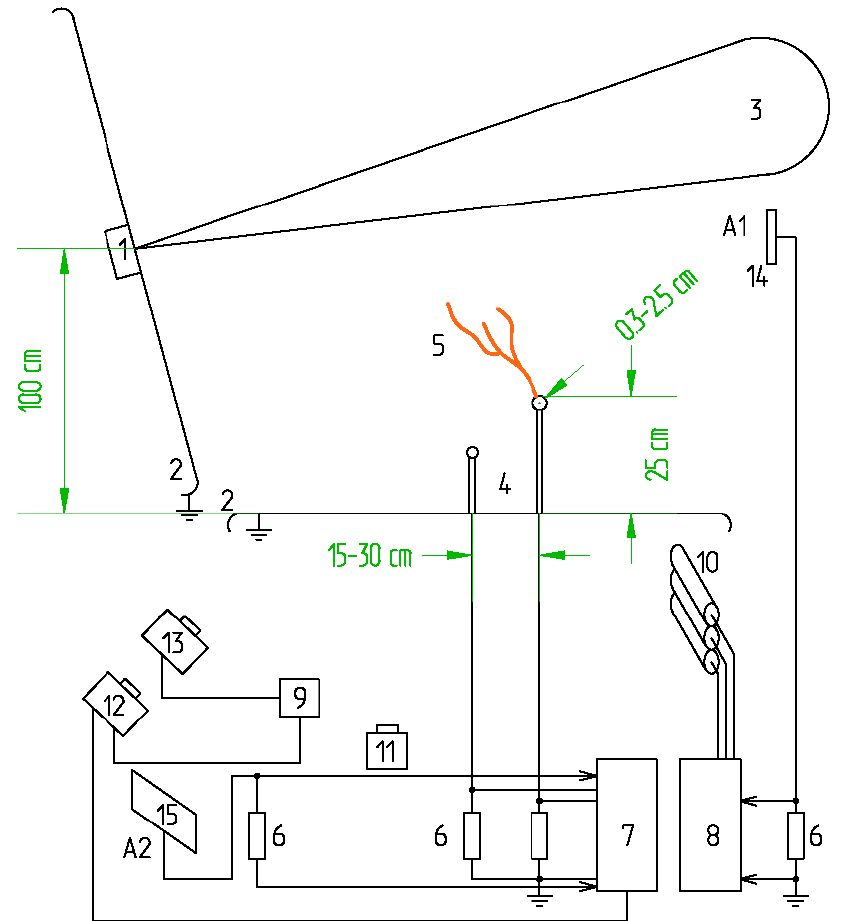
Figure 1. First scheme of experimental and measurement setup: 1—charged aerosol generator; 2—grounded electrostatic screens; 3—artificial thunderstorm cell; 4—rod electrodes; 5—upward streamer discharge; 6—shunts; 7,8—digital oscilloscope; 9—trigger generator; 10—system of photomultipliers; 11—digital photo camera; 12—photomultiplier; 13—CCD-camera; 14, 15—flat antennas.